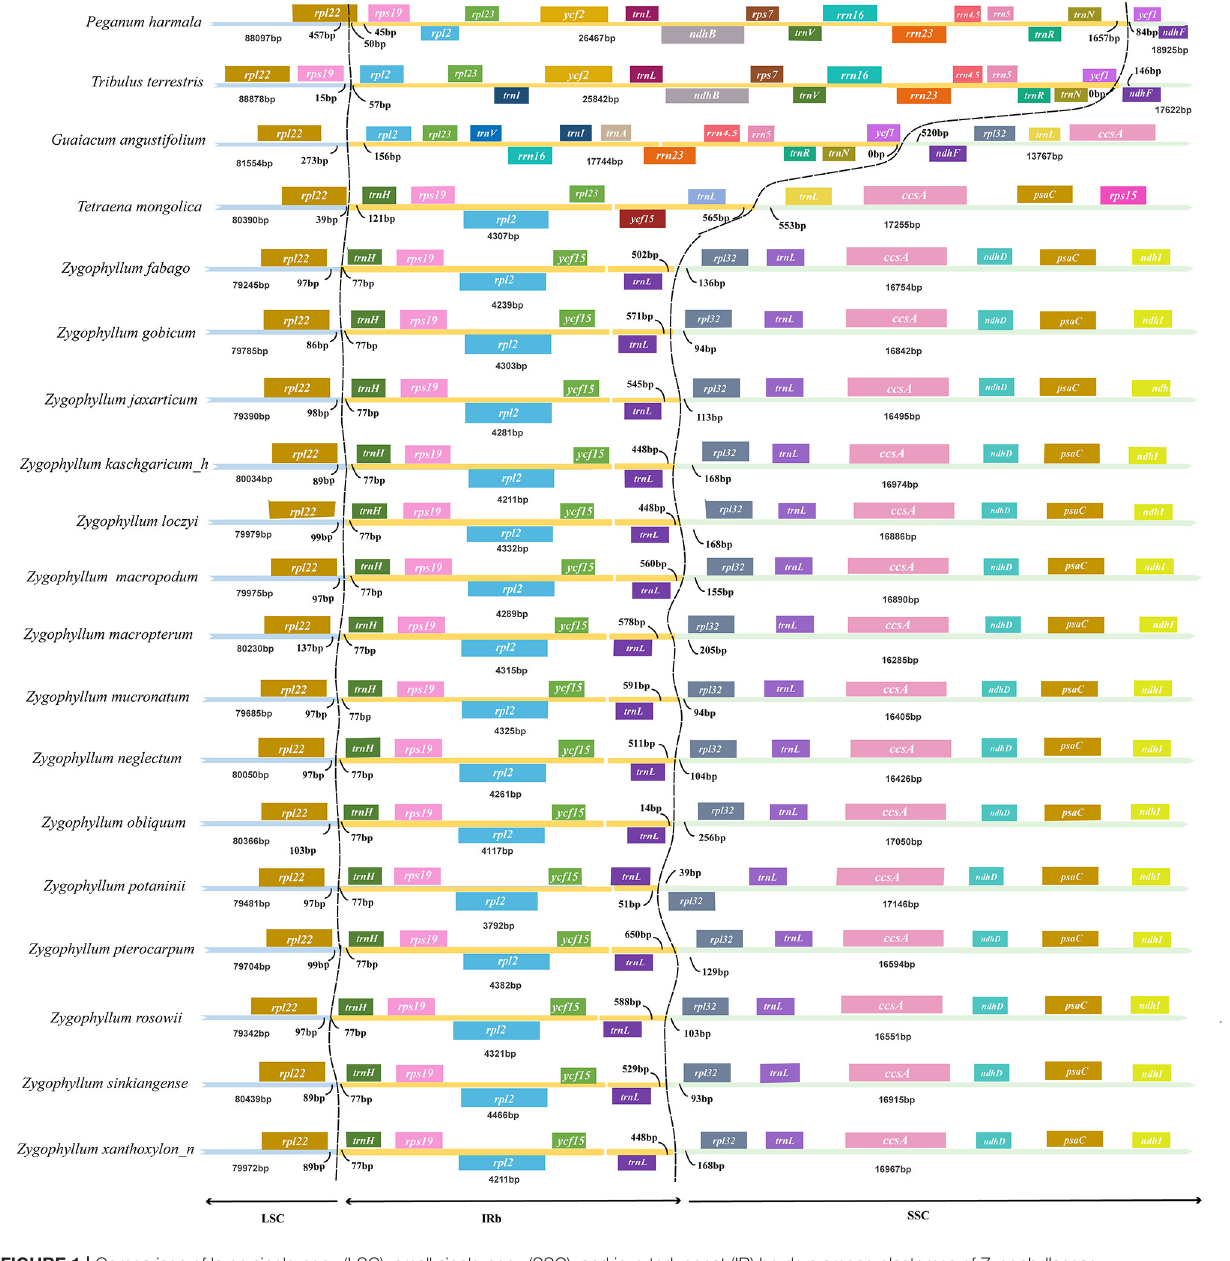
of the hypervariable regions were in the IRs, which had more conserved